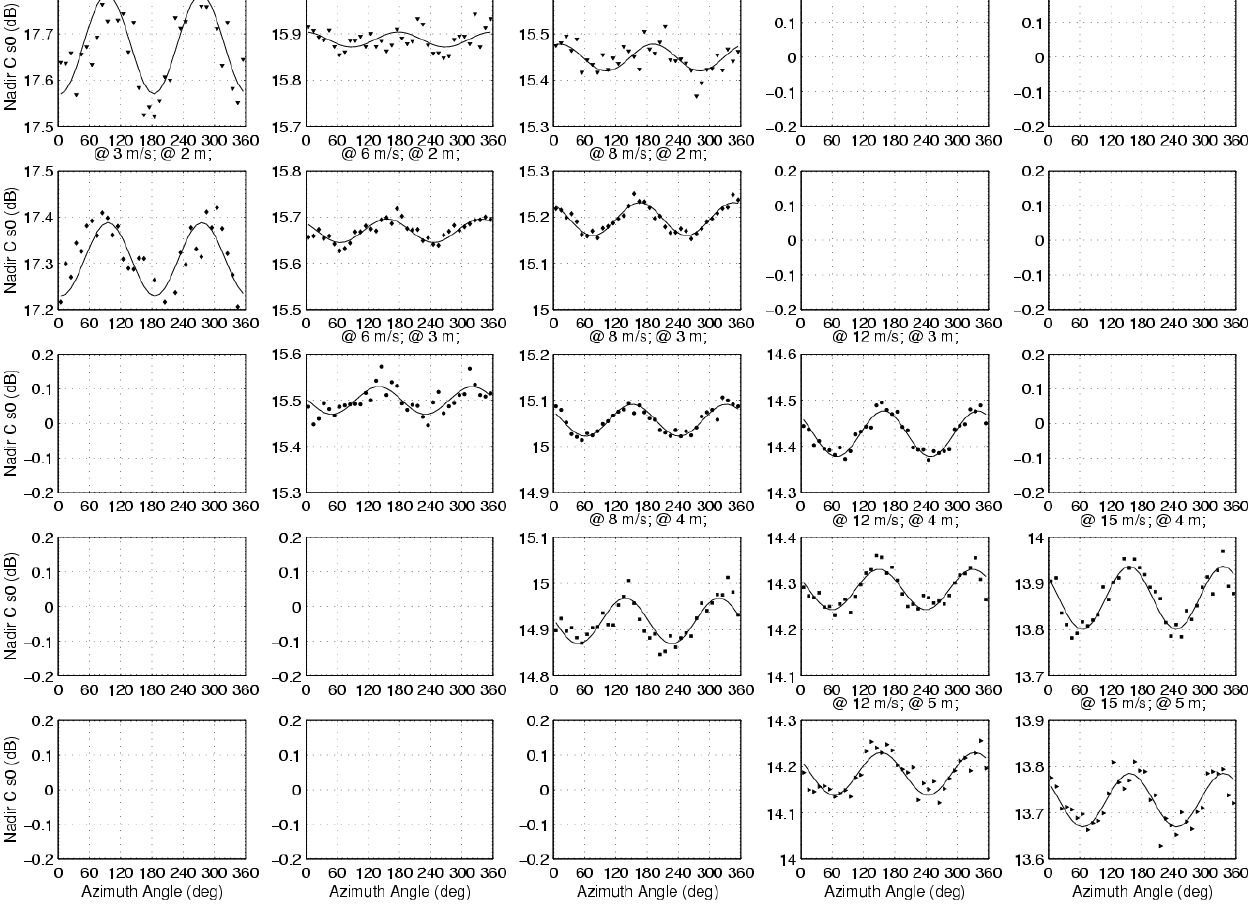
Figure 5. Variation of C-band altimeter radar cross-section with the relative azimuth angle for five different wind speeds from low to high wind forces and different classes of SWH of 1 m